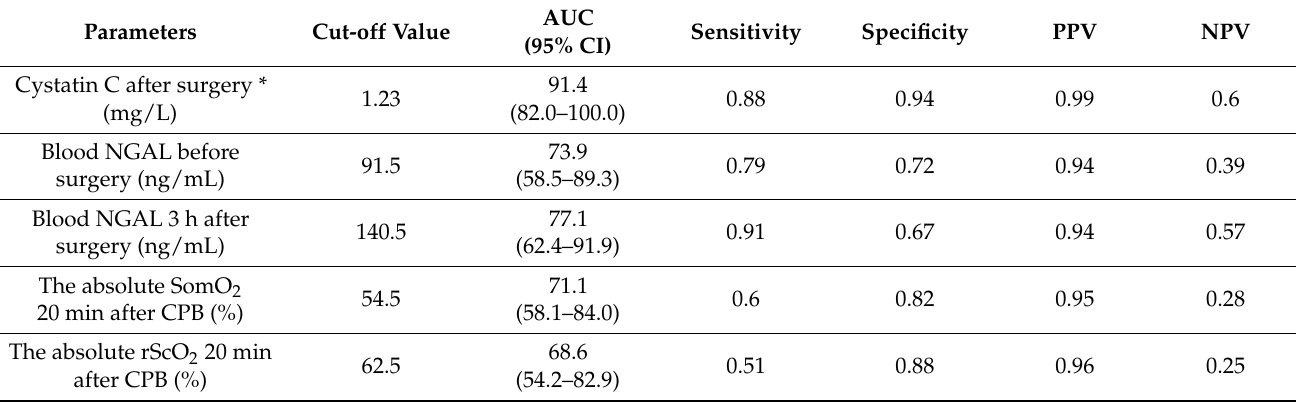
Figure 3. NIRS brain saturation measured in the operating room in AKI and non-AKI patients at time-points specified in methods ( p values for comparison between AKI and non-AKI patients at specified time points. {1}—before anaesthesia induction, {2}—directly before skin incision, {3}—after sternum opening, {4}—20 min after aortic cross-clamping, {5}—40 min after aortic cross-clamping, {6}—20 min after aortic cross-clamp removal, {7}—20 min after weaning from CPB, {8}—40 min after separation from CPB, {9}—60 min after separation from CPB). Table 1. Demographic, clinical, and laboratory characteristics and data of cardiac surgery. Table 2. Cut-off values for pre- and postoperative blood NGAL, postoperative cystatin C, the absolute SomO 2, and the absolute rScO 2 in CS-AKI prediction (based on AUC ROC